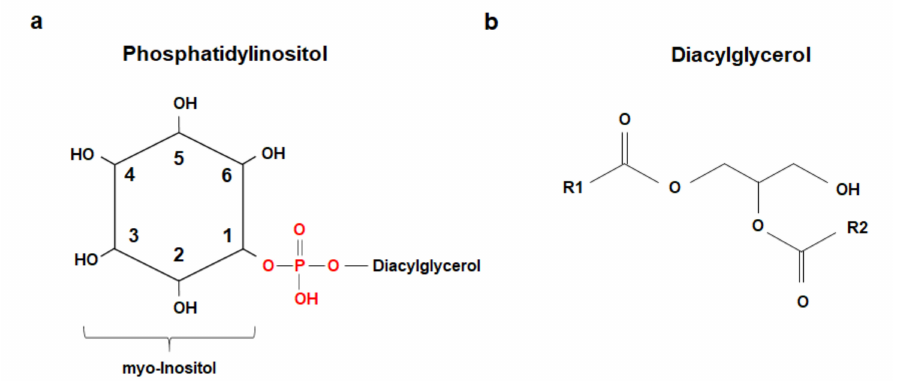
Figure 1. ( a ) Schematic representation of Phosphatidylinositol, showing the unphosphorylated hydroxyls within the myo-inositol head group, the phosphodiester bond (in red), and the attached diacylglycerol. ( b ) Generic structure of a diacylglycerol. Most phosphoinositides possess stearoyl (R1) and arachidonoyl (R2) chains.